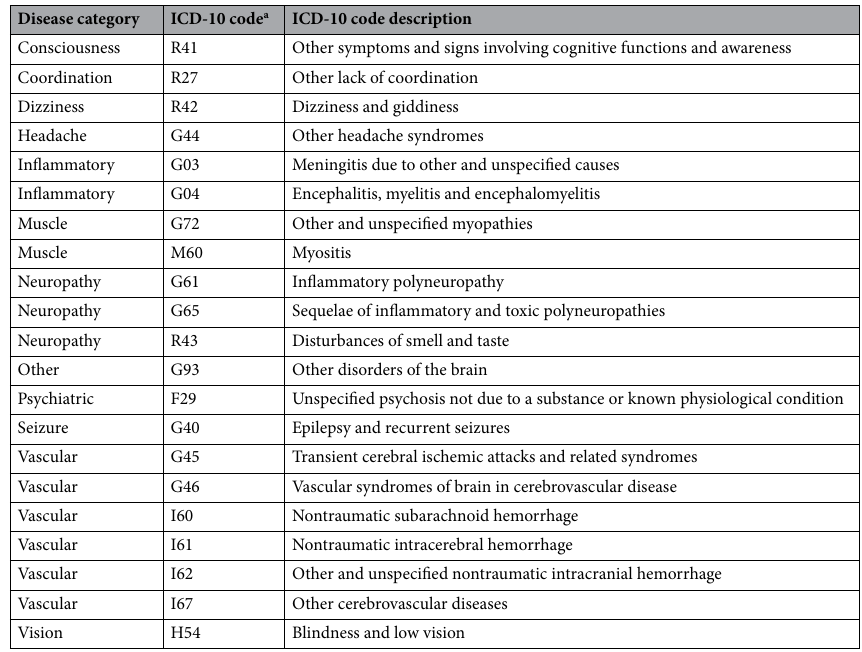
Table 3. Mapping of neurological disease categories to ICD-10 category codes and their descriptions. a To standardize the collection of ICD codes across diverse contributing healthcare systems and to mitigate coding discrepancies, we used ICD codes at the categorical level ( e.g. , the first 3 alphanumeric characters before the decimal point for